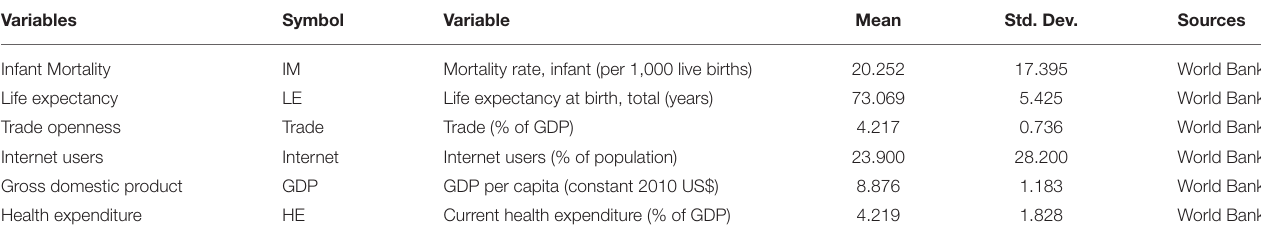
TABLE 1 | Definitions and data sources.